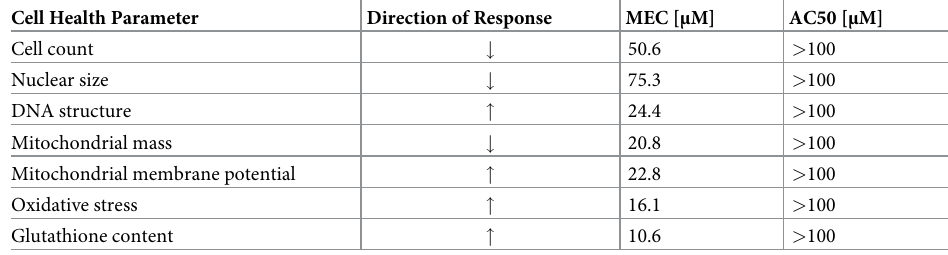
Table 4. CPL302-253 toxicity on NHB cells. The cells were cultured for 48 h in the presence of the compound. Cell health parameters were studied on fluorescent cell imager after staining. Minimum Effective Concentration (MEC) that alters the cell health parameters and AC50 (concentration at which 50% maximum effect is observed) in compari- son to vehicle control was calculated for each cell health parameter. Cell Health